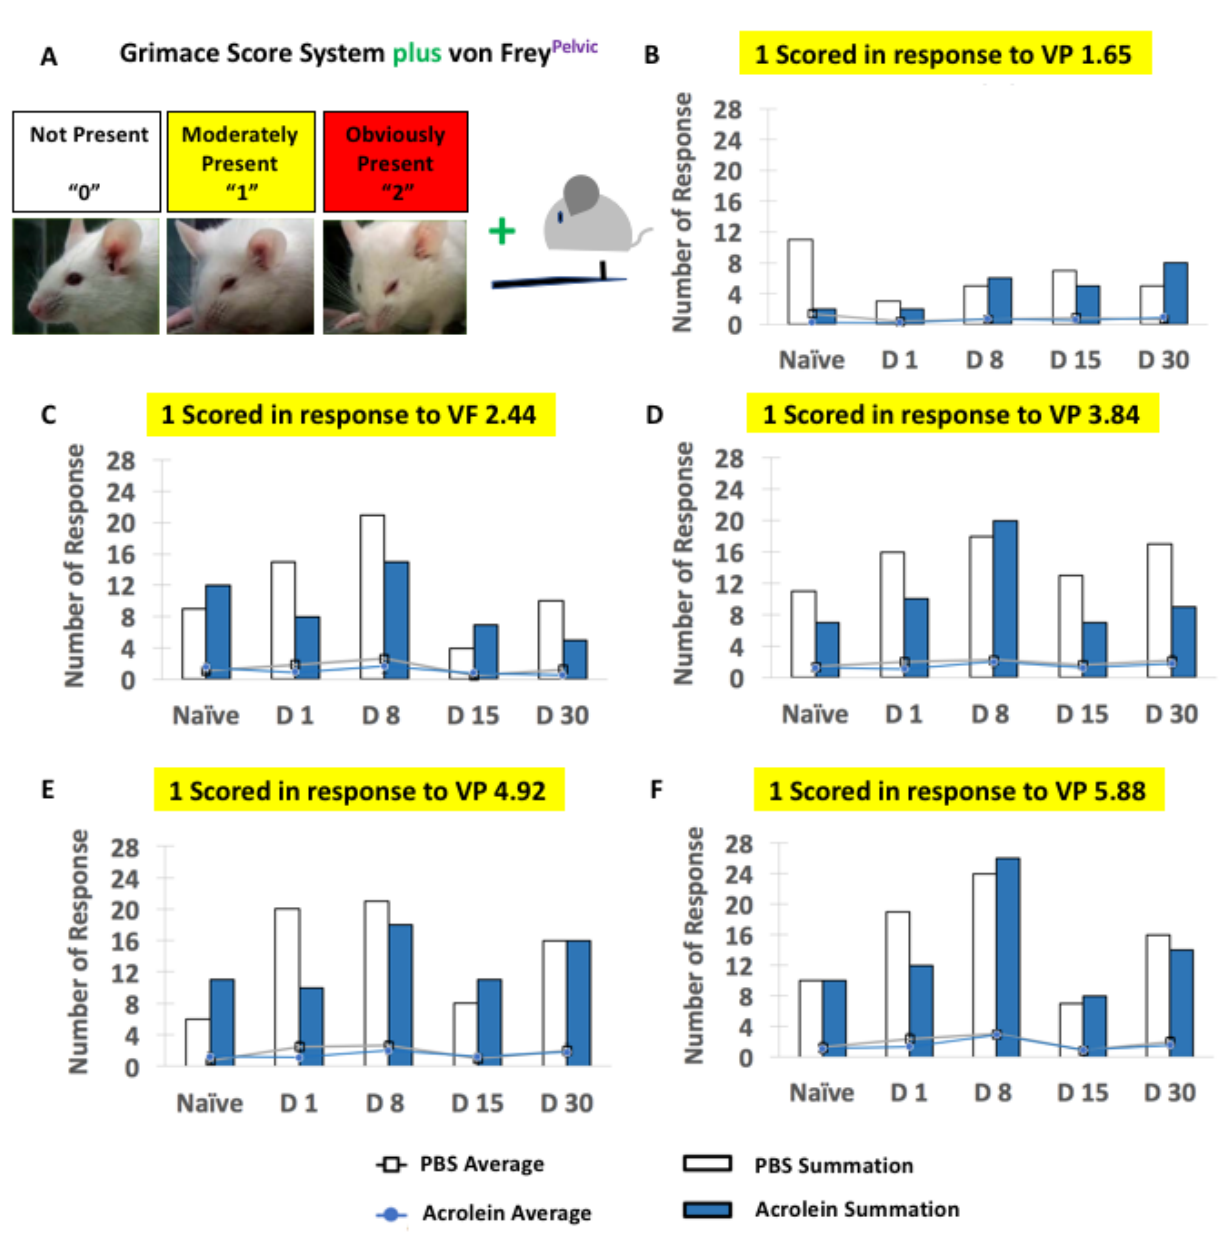
Figure 6. Concurrent assessment of the facial expression of pain and pelvic sensitivity shown in PBS vs. acrolein mice on the time points of naïve, days 1, 8, 15 and 30 pi as determined by the grimace scoring system and the application of von Frey filaments to the pelvic area. ( A ) Description of the grimace scoring system with a combination of the application of von Frey filaments to the pelvic area. The number of responses (bar graphs) and mice that scored 1 in response to the application of the von Frey filament were 1.65 ( B ), 2.44 ( C ), 3.84 ( D ), 4.92 ( E ) and 5.88 ( F ).